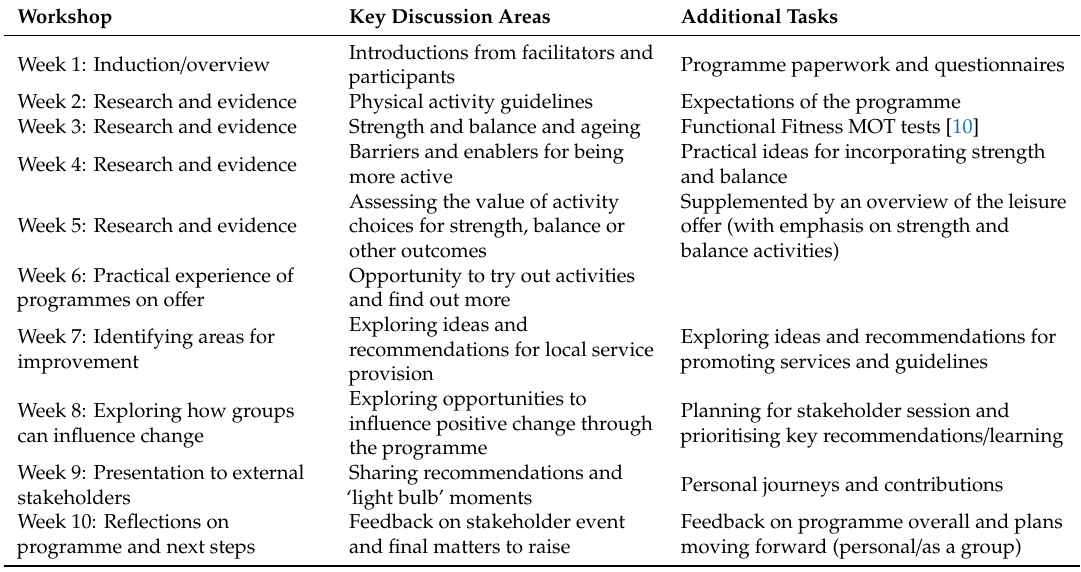
Table 1. Overview of co-creation workshop